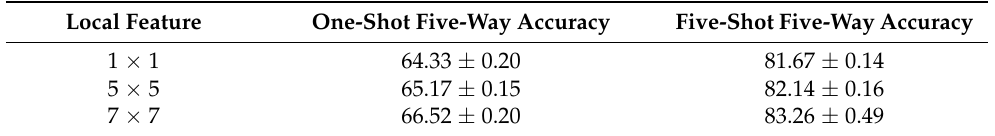
Table 5. Analysis of different features chosen for contrastive learning effects on one-shot five-way vs. five-shot five-way task accuracy (%). There is a 95% confidence interval associated with all results.